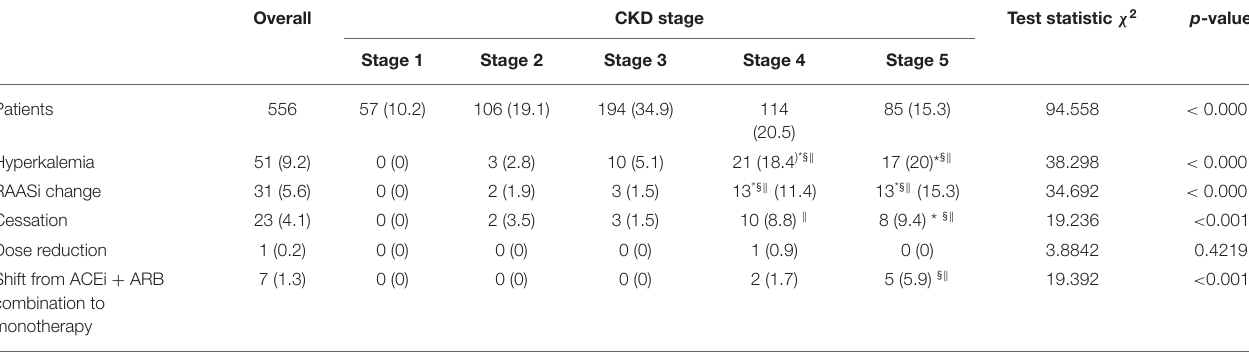
TABLE 2 | Incidence of hyperkalemia and changes in RAASi therapy in the study cohort, overall and by CKD